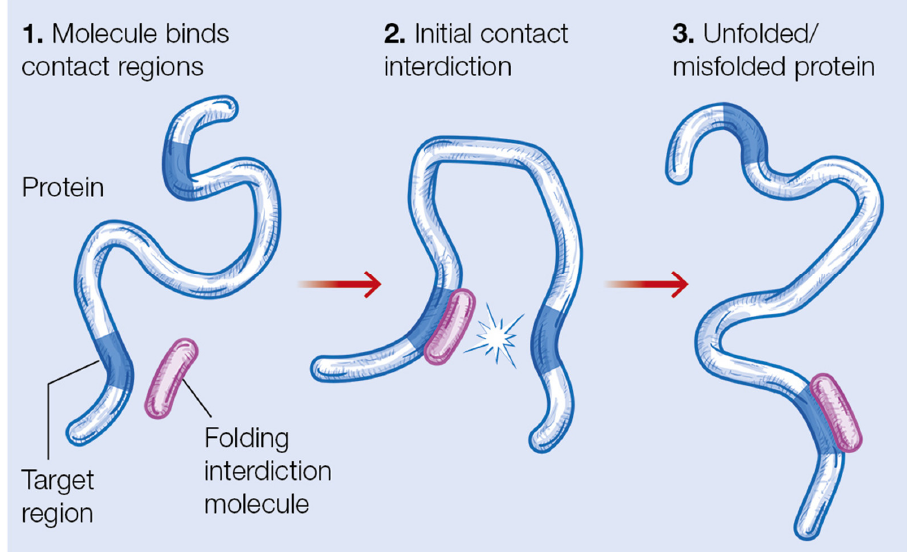
Figure 3. Protein folding interdiction, based on the identification of a FITR target.